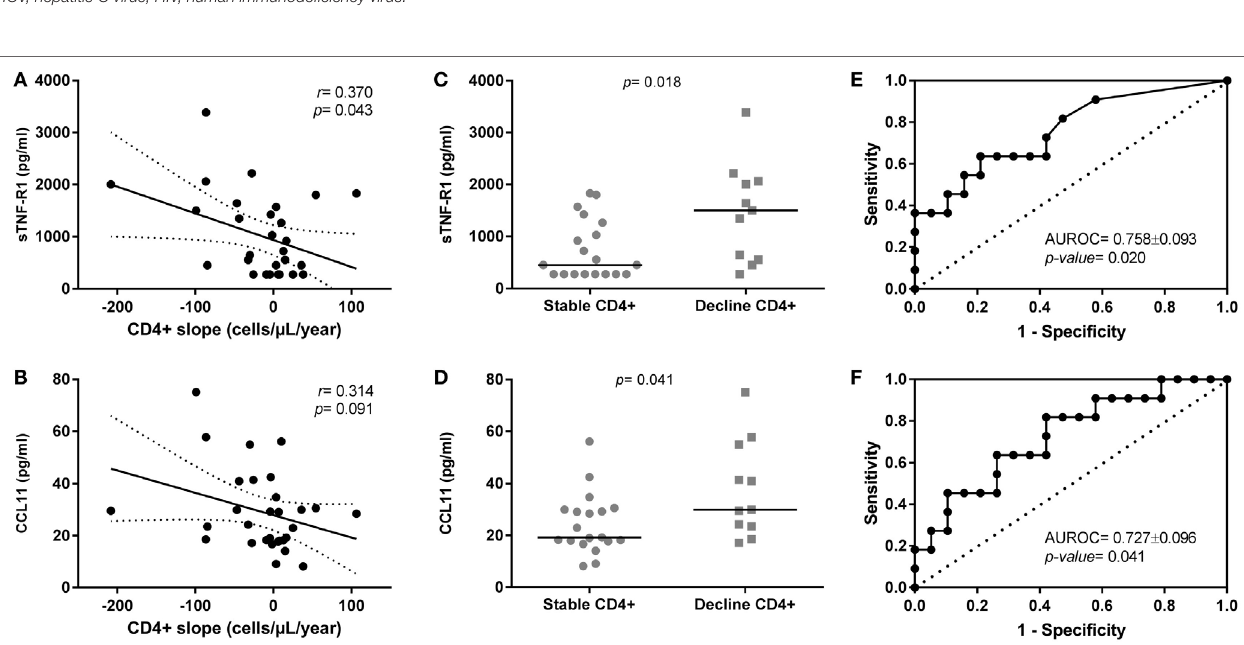
FigUre 1 | Relationship of sTNF-R1 and CCL11 plasma levels with CD4 + T-cells evolution in human immunodeficiency virus (HIV) elite controllers (HIV-ECs) with sustained virologic control. (a,b) Show dot-plot graphs of sTNF-R1 and CCL11 vs. CD4 + slope in the whole population of HIV-ECs; (c,D) show levels of sTNF-R1 and CCL11 in the two groups of HIV-ECs (stable CD4 and decline CD4); (e,F) show the receiver operating characteristic curves for sTNF-R1 (e) and CCL11 (F) as predictors of CD4 + decline in HIV-ECs.